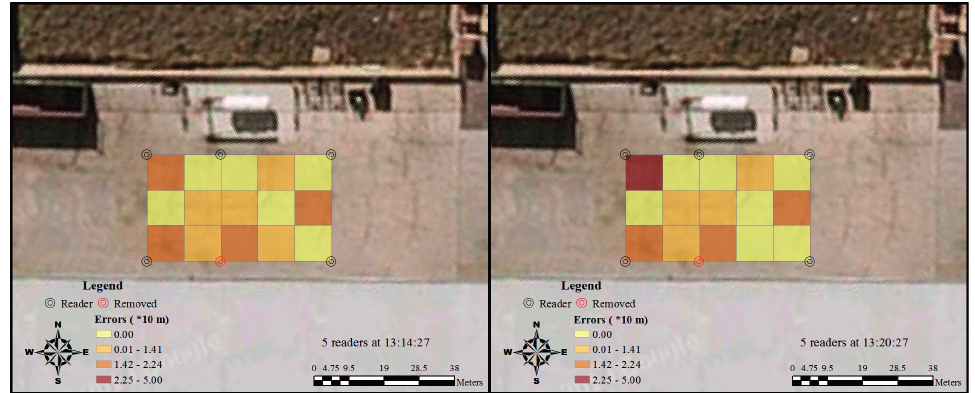
Figure 7. Temporal variation of RFID errors distribution in the discrete grids by five